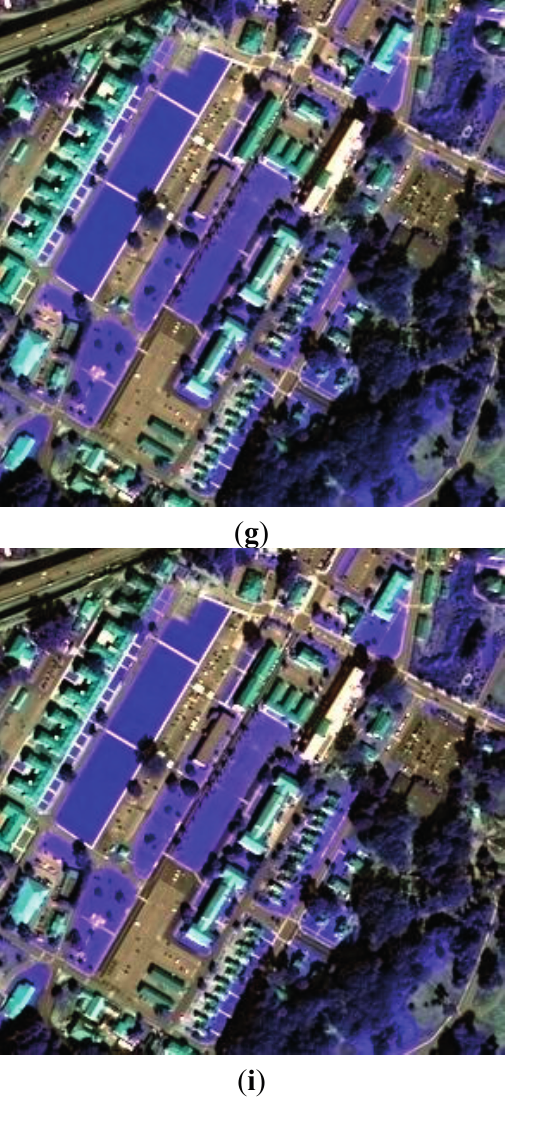
Figure 4. A subset, marked in the left white box in Figure 1, of different fusion results at the reduced scale of the WorldView-2 group 1 dataset. Bands 3, 5 and 6 are combined for RGB display. ( a ): Observed at a 2.0-m spatial resolution; ( b ): EXP; ( c ): GS; ( d ): GS-spectrally consistent; ( e ): GLP-ECB; ( f ): GLP-ECB-spatially consistent; ( g ): GLP-M3; ( h ): GLP-M3-spectrally consistent;( i ): GLP with s = 0.75; ( j ): Spectrally consistent GLP with s =